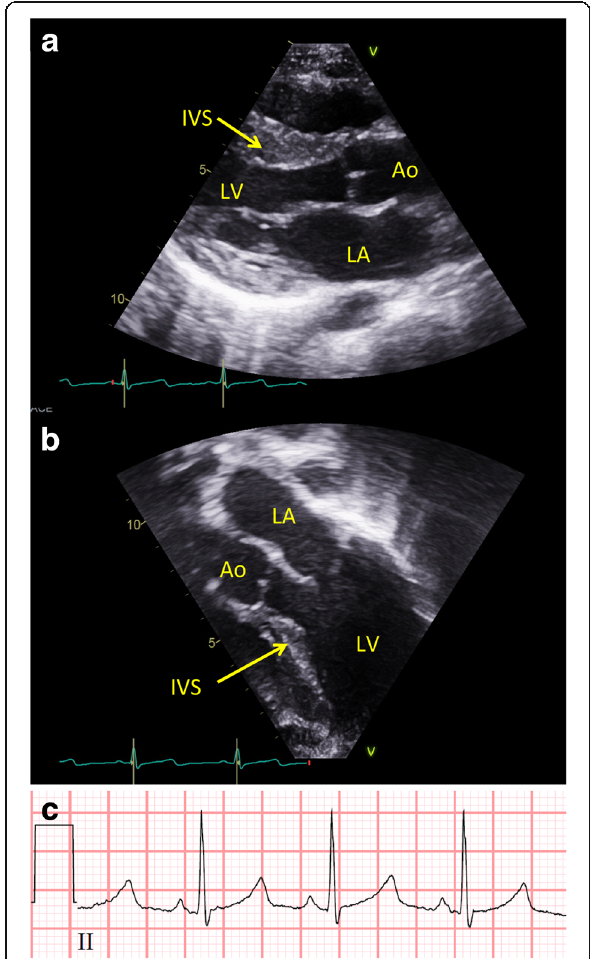
Fig. 1 Cardiac hypertrophy in patient 2. Transthoracic echocardiography showing the left ventricle in a parasternal long axi and b apical 3- chamber view. Please note how the hypertrophy predominantly affects the interventricular septum with relative sparring of the apical and posterior regions. Red marker on EKG trace shows temporal relation to heart cycle. LV, left ventricle; Ao, aorta; LA, left atrium; IVS, interventricular septum. c Standard electrocardiogram (EKG) in patient 2. Note the borderline prolonged